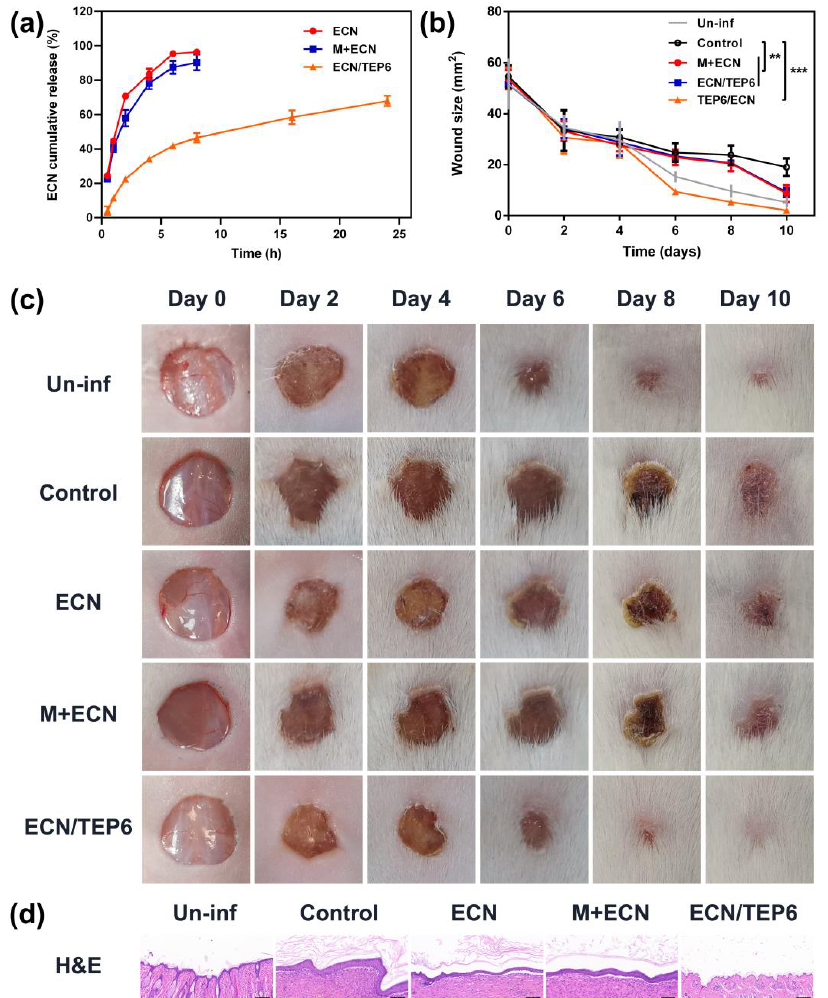
Figure 5. ( a ) Time-dependent cumulative ECN release curves. Each point represents the mean ± SD, n = 3. ( b ) Wound size changes in S. aureus -infected mice from day 0 to day 10. The significance of the differences seen in ( b ) was assessed using a one-way ANOVA and multiple comparisons. ** p < 0.01, *** p < 0.001. ( c ) Representative images of wounds treated with several schemes within 10 days. ( d ) H&E staining of wound slices harvested from mice of each group on day 10 (scale bar = 100 µ